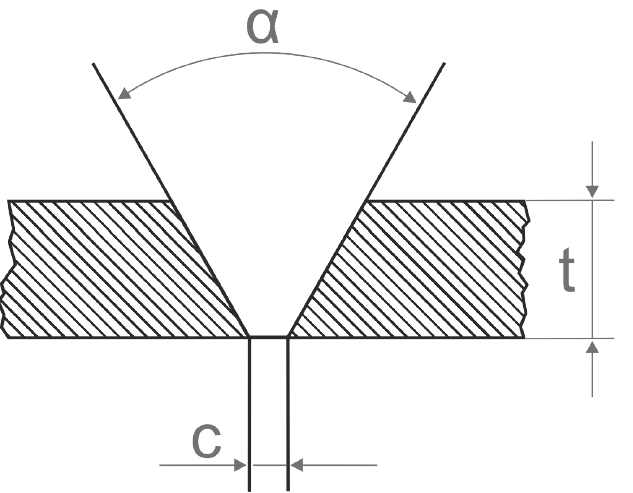
Figure 1. The geometry of sheet edge: α —an angle of the groove edge; t—the thickness of the weldment; c—root opening.